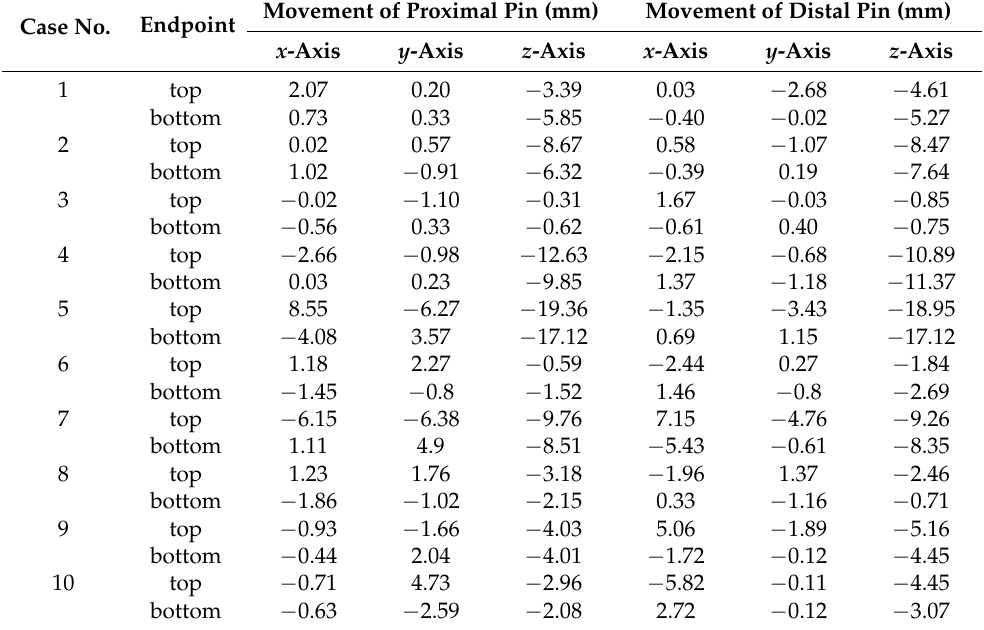
Table 6. Displacement of the Hansson pins.